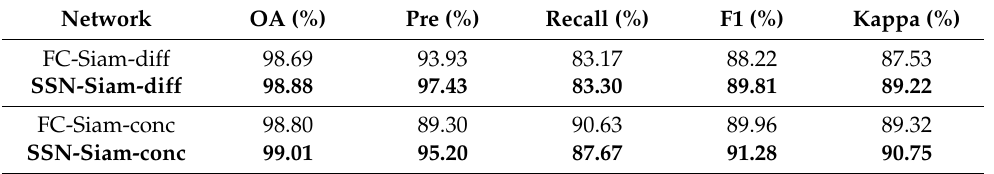
Table 6. Quantitative results of transfer learning experiment for Yellow River–Farmland-A dataset.